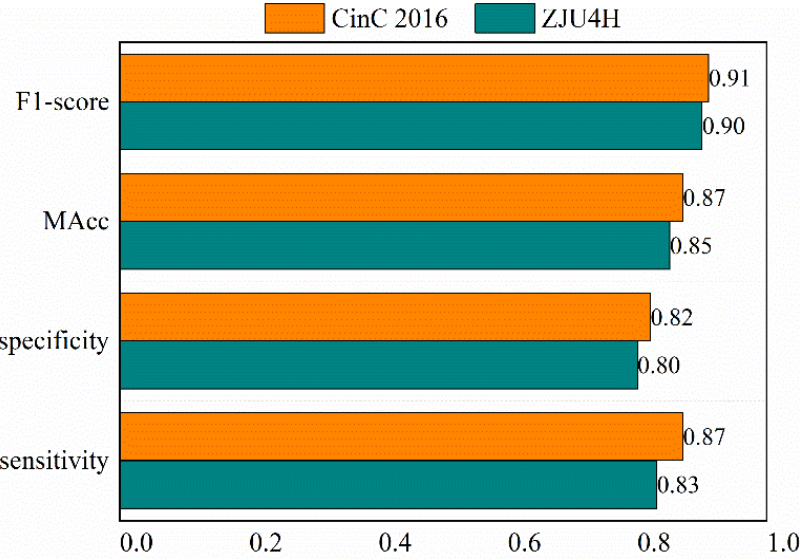
Figure 6. Summary of performance of Net_3 with setting of class weight evaluated using the dataset (ZJU4H) from the Fourth Affiliated Hospital of Zhejiang University, School of Medicine and Physionet Challenge 2016 (CinC 2016).